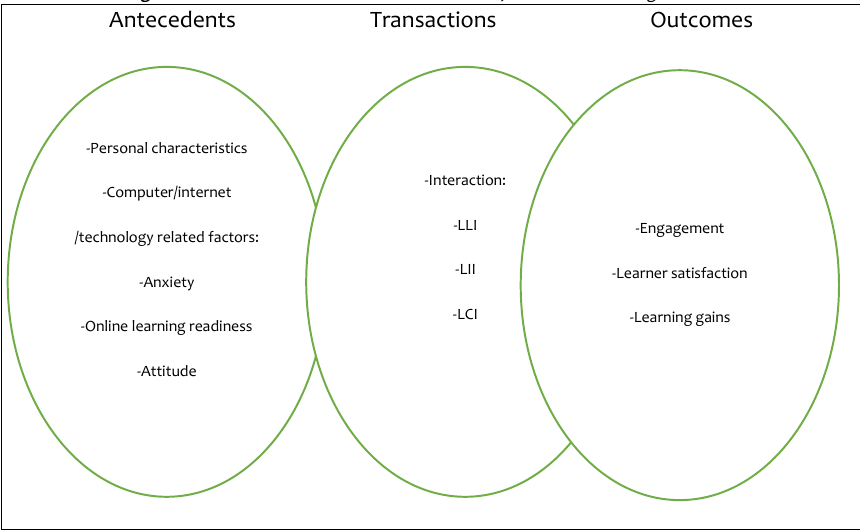
Figure 1 . A Theoretical Evaluation Framework for Online Learning